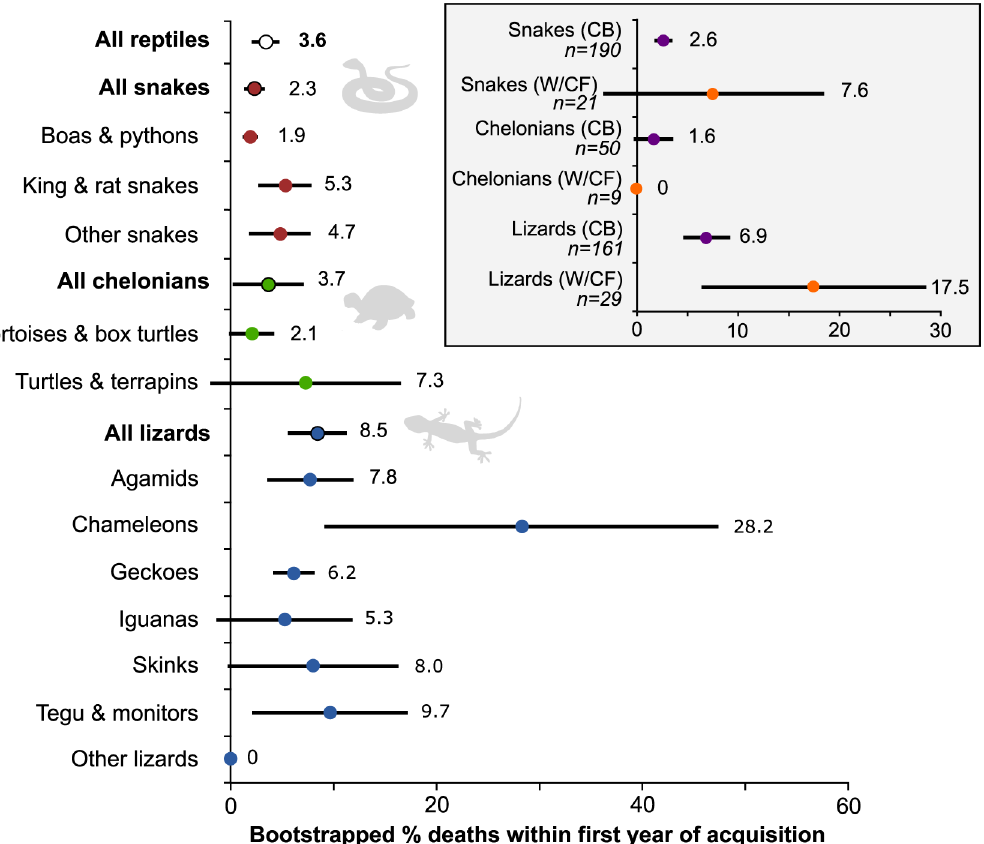
Fig 1. Bootstrapped reptile mortality rates within first year of acquisition. The bootstrapped proportion of deaths within first year of acquisition for commonly kept reptile groups. Circles indicate mean mortality rate based on x 1000 bootstrap samples obtained from direct questions, lines represent 95% confidence intervals. Inset displays mean mortality rates for snakes, chelonians and lizards analysed separately for those reported to be captive bred (CB) and those reported to be either wild (W), or captive farmed (CF). Reptiles reported to be unknown origin (U) may represent captive bred or wild individuals and were therefore excluded. Refer to Table 2 for n numbers used in analysis of mortality